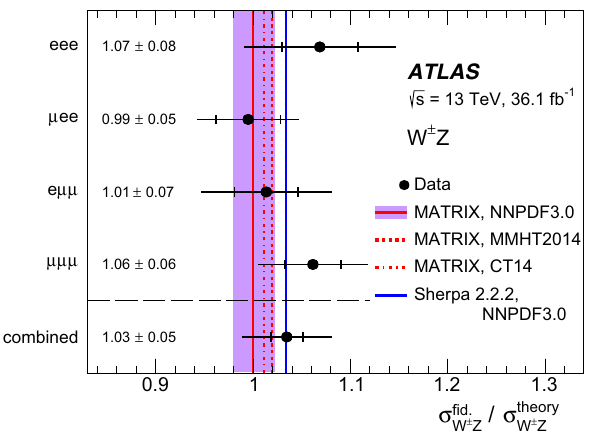
0.9 σ / fid. σ theory Z ± W Z ± W Fig. 2 Ratio of the measured W ± Z integrated cross sections in the fiducial phase space to the NNLO SM prediction from MATRIX in each of the four channels and for their combination. The inner and outer error bars on the data points represent the statistical and total uncertainties, respectively. The NNLO SM prediction from MATRIX using the NNPDF3.0nnlo PDF set is shown as the red line; the shaded violet band shows the effect of QCD scale uncertainties on this predic- tion. The prediction from MATRIX using the MMHT2014 and CT14 PDF sets and the NLO prediction from Sherpa 2.2.2 are also displayed as dashed-red, dotted-dashed-red and blue lines,